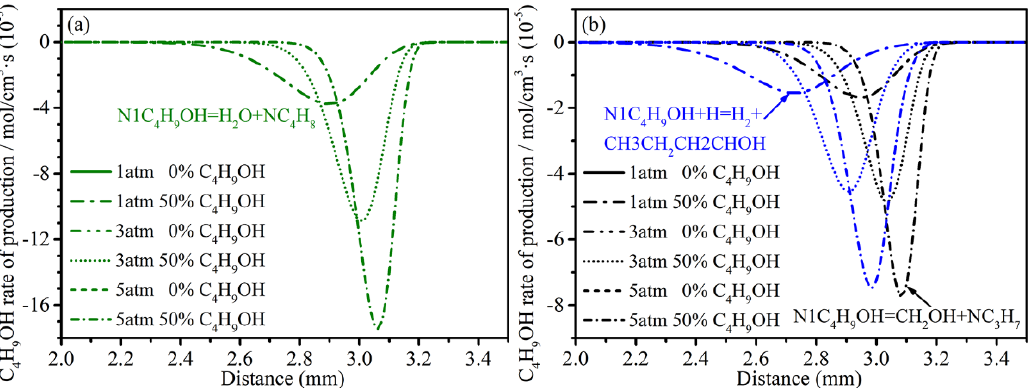
Figure 5. Rate of production of C 4 H 9 OH, with different levels of n -butanol at different pressures. ( a ) R942, ( b ) R936 and R3665.